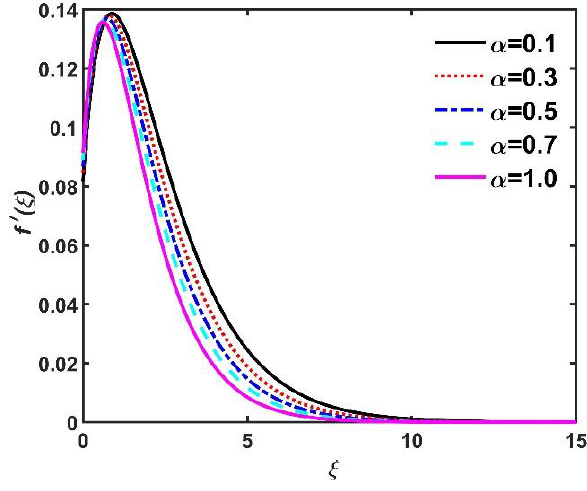
Figure 2. Impact of 𝛼 on 𝑓′(𝜉) .